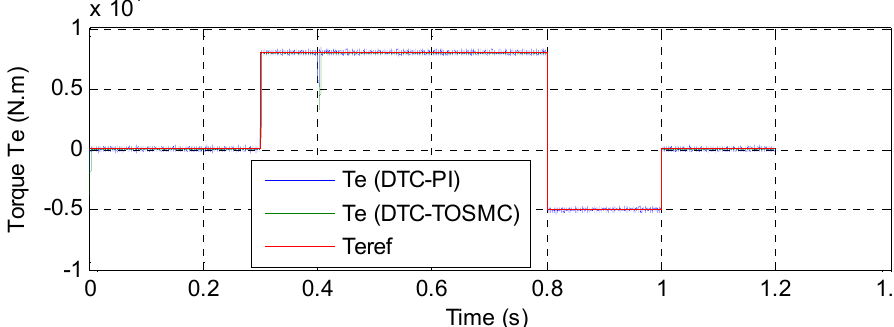
Figure 8. Electromagnetic torque.